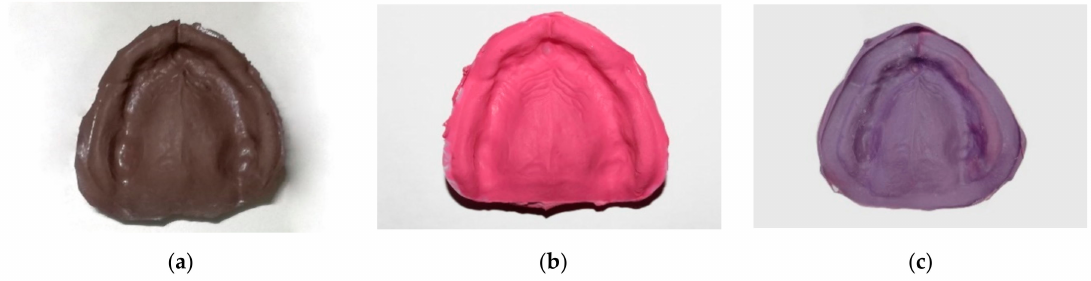
Figure 2. Physical impressions made of: ( a ) polysulfide; ( b ) polyvinyl siloxane; ( c )